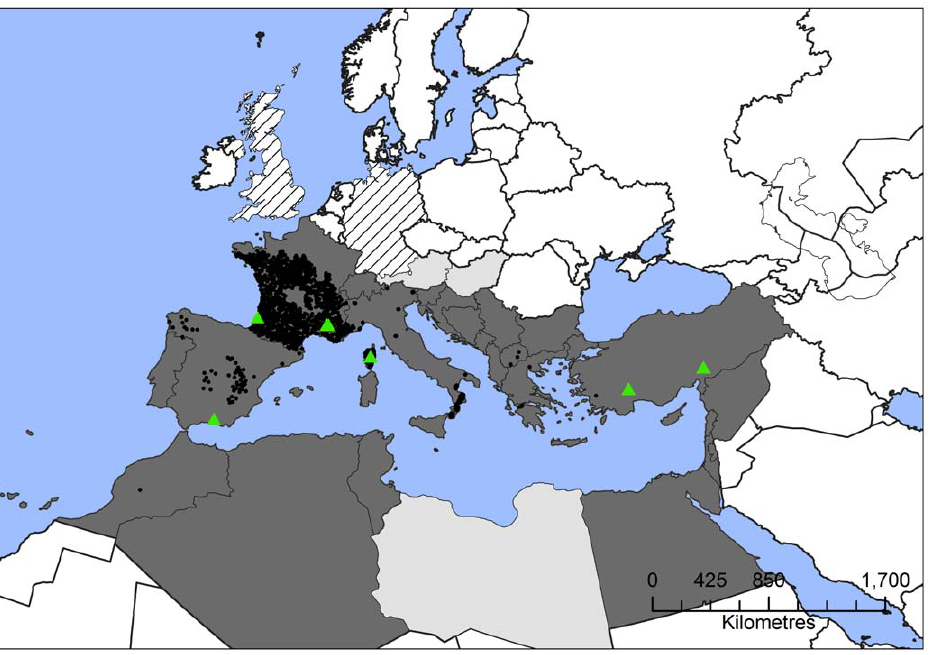
Figure 2. Known distribution of Thaumetopoeapityocampa in Europe, Asia and North Africa, combining records from before and after 1990. Black circles indicate known locations for T. pityocampa, green triangles are locations from which impact data has been reported. Countries are shaded to indicate areas where T. pityocampa has been reported as occurring regularly (dark grey), seldom found (light grey), presence unknown (cross-hatched) and absent (white). Projection: Albers equal-area.